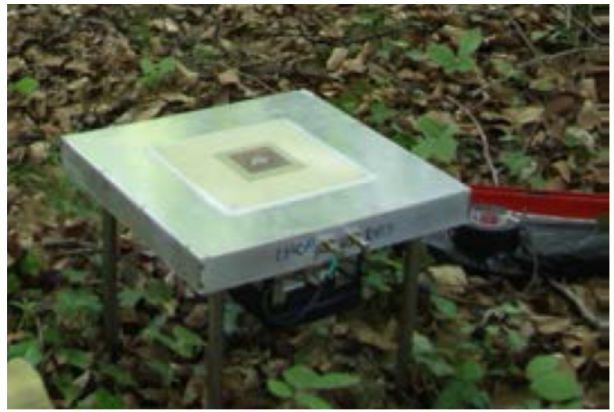
Figure 3. Dual-polarization up-looking antenna and receiver (behind the antenna) installed at La Fageda d’en Jordà (Girona, Spain).